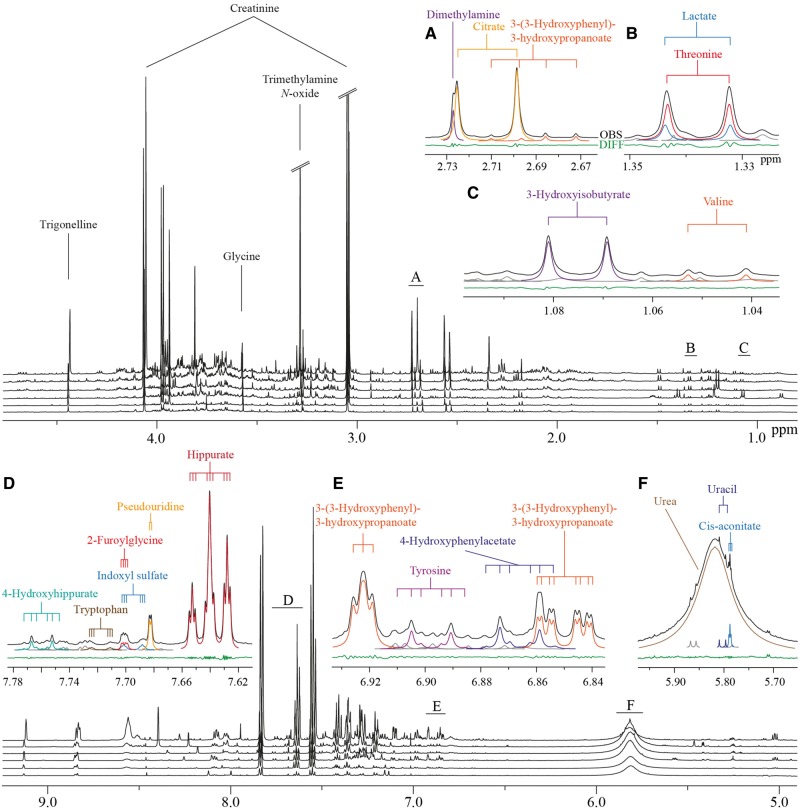
Characteristic 1H NMR spectra of human urine from six subjects, and illustration of the sophisticated line shape fitting analyses. Alignment of spectra from six subjects is shown. Heavily overlapping signal structures in multiple areas are typical for these spectra. The insets marked from A to F illustrate how line shape fitting analyses, incorporating prior knowledge on the individual molecular attributes, can robustly solve the overlap and lead to reliable quantification of the metabolites.20,21 Black lines represent the observed spectra and the coloured lines represent the fitted signals. Grey lines indicate currently unidentified signals. The green line at the bottom illustrates the difference between the observed spectrum and the fitted signals. The coupling trees above the spectra demonstrate the multiplet structures directly linked to the molecular attributes and used as constraints in the line shape fitting analyses.20,21